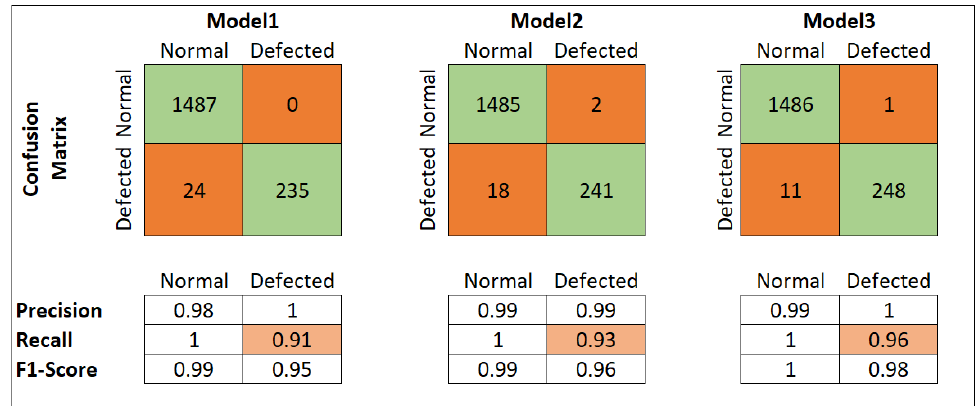
Figure 9. Confusion matrices of models on all data